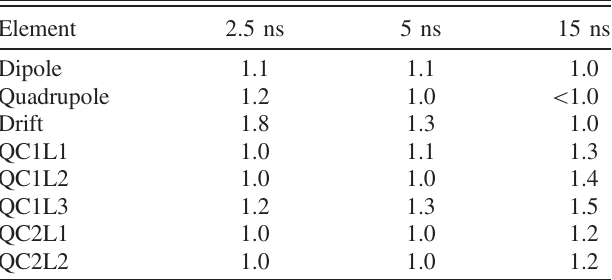
TABLE III. Threshold SEY for multipacting for all the ring components.